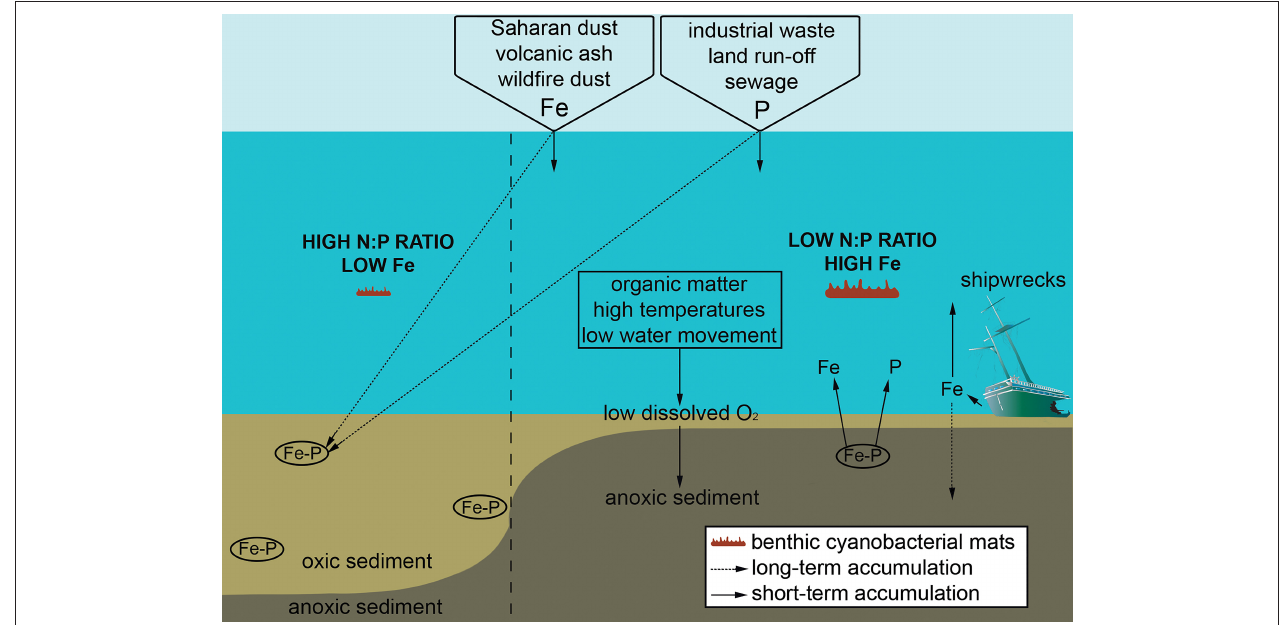
FIGURE 3 | Schematic diagram representing how sedimentary changes support the growth of benthic cyanobacterial mats, focusing on the roles of low dissolved oxygen (O 2 ) at the sediment-water interface leading to sediment anoxia and subsequent release of sedimentary iron (Fe) and phosphate (P). Some main external sources of Fe and P are included, with long-term accumulation within sediments and short-term accumulation in the water column